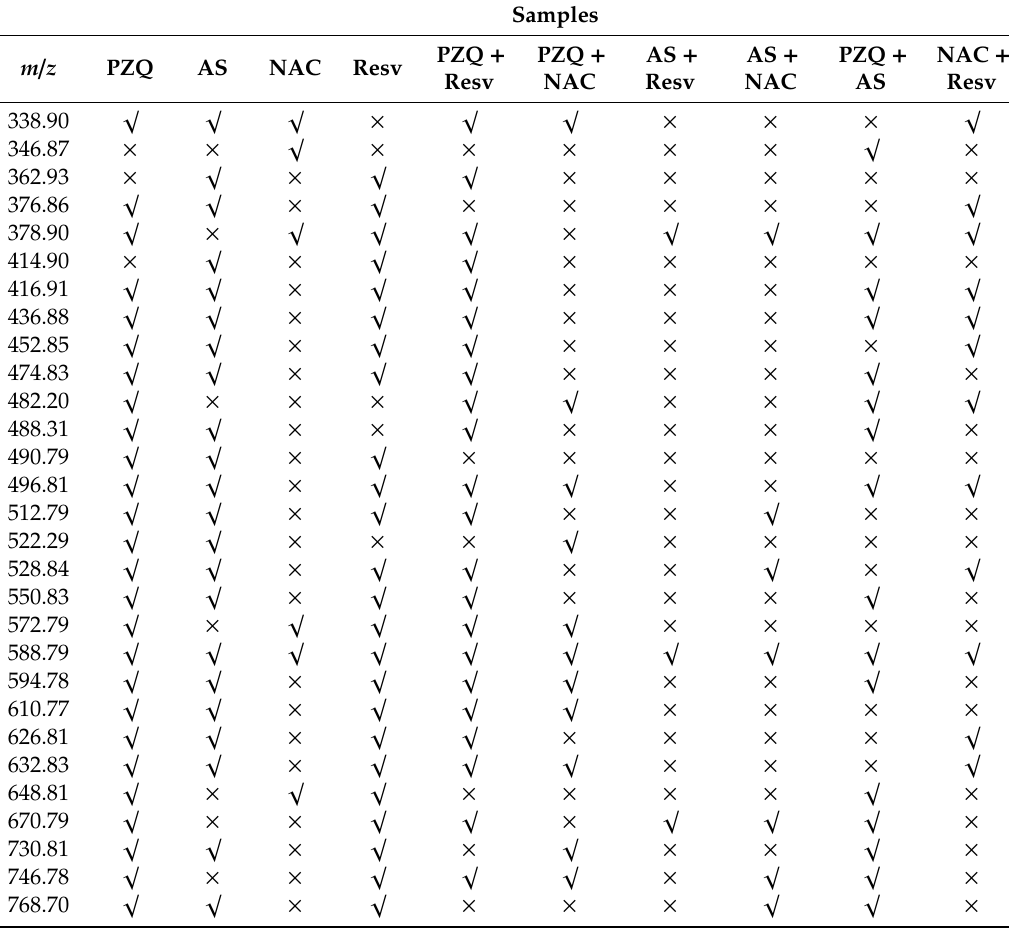
Table 1. Evaluation of inhibition of the formation of precursors metabolites and DNA adducts detected in the control sample by drugs and antioxidants alone and combined. The structures of these m / z compounds are represented in Figure 1. The tick and cross indicate the presence ( the correspondent metabolite or DNA adduct in the samples analyzed in this